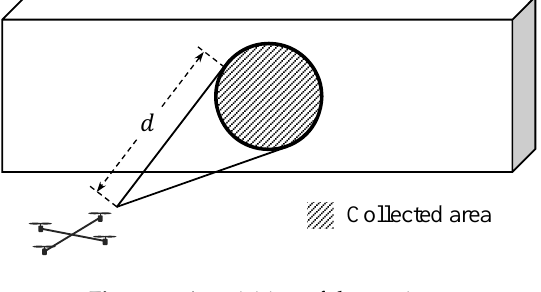
Figure 2. Acquisition of data